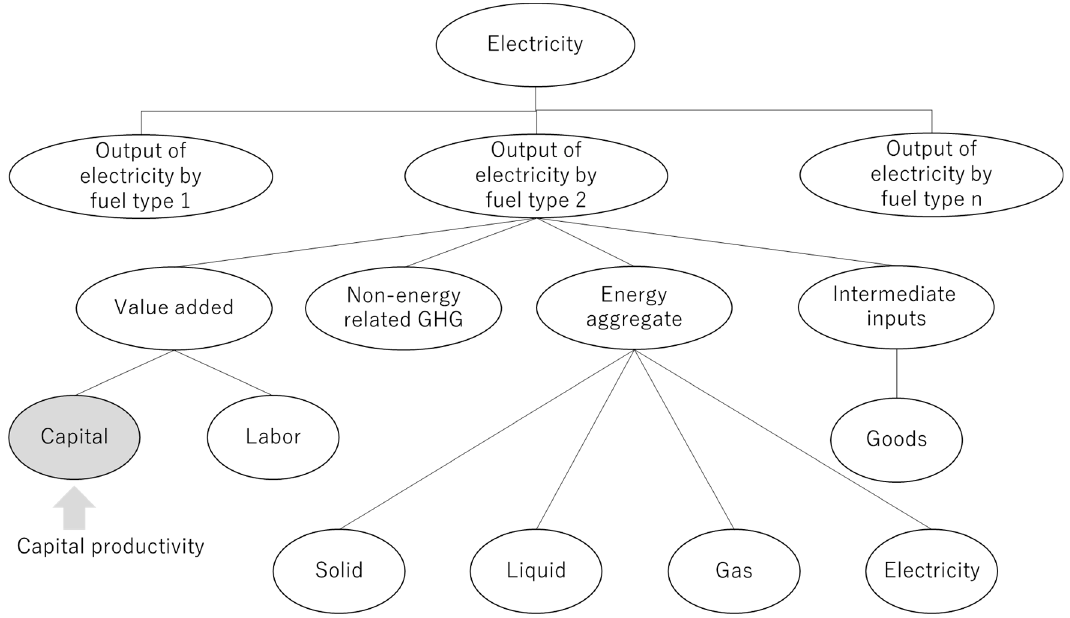
Figure 2. The structure of electricity production. Diagonal and straight lines denote the Leontief and logit functions, respectively.